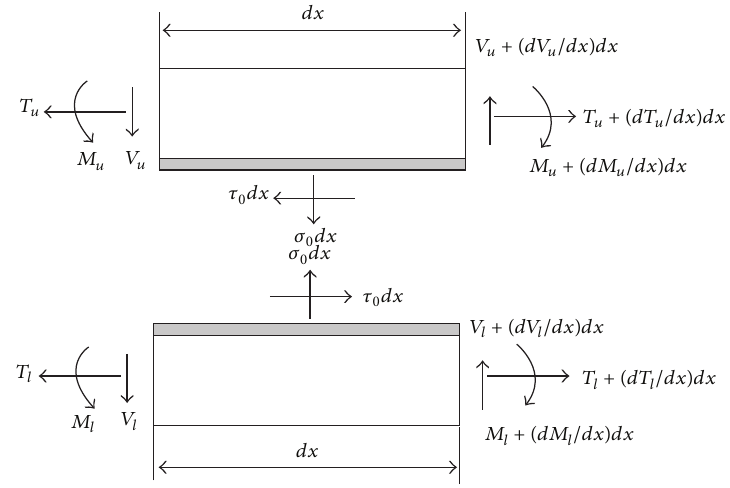
Figure 3: Free body diagram of joint with adhesive